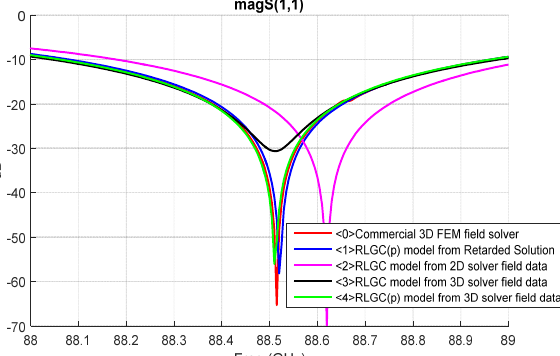
Figure 16: Magnitude of S11 from 88 GHz to 89 GHz